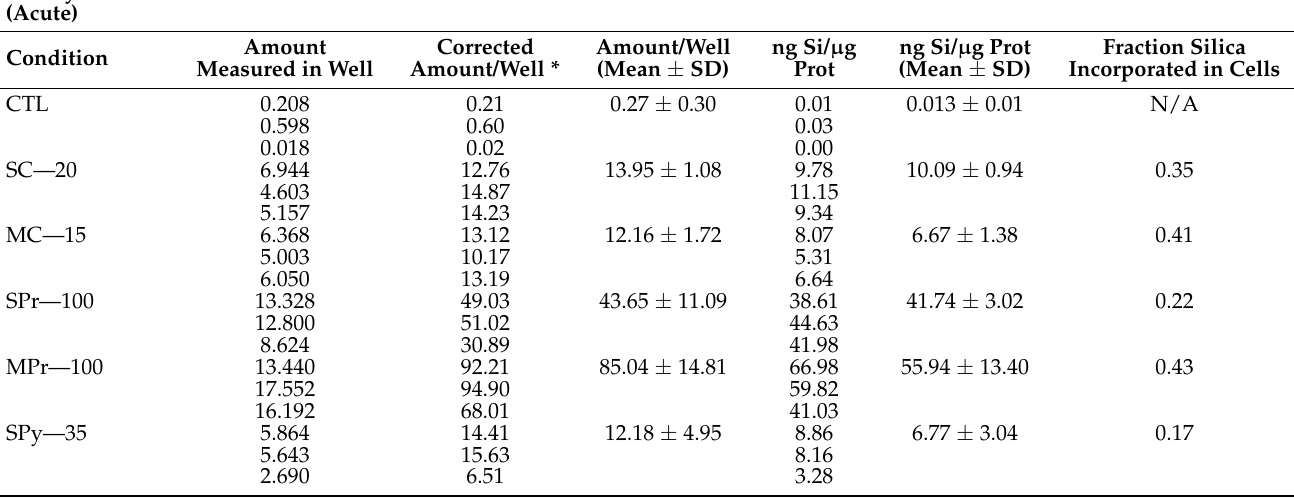
Table 2. Determination of silica internalized in cells after acute